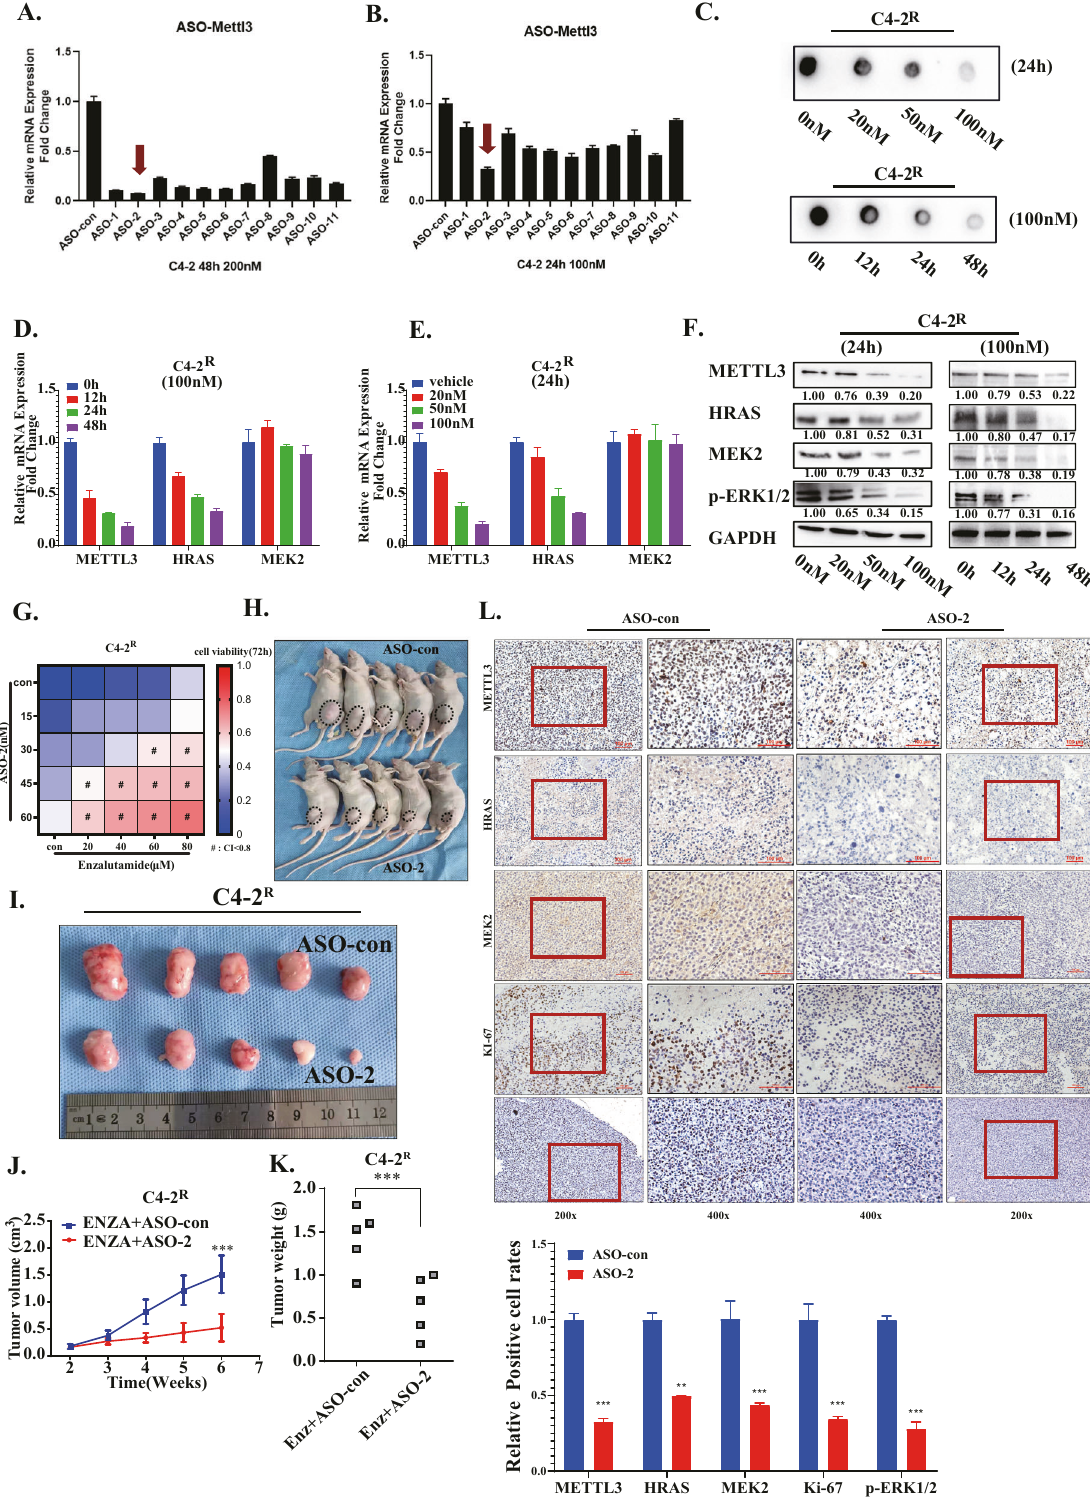
ASO design and usage We used the online RNA-motif prediction tool (Sfold) to screen 20 bp ASO sequences speci fi cally targeting METTL3 mRNA [27 – 30]. The mRNA sequence of METTL3 was obtained from NCBI. We selected 10 candidate ASOs including desired motifs [31] and modi fi ed them in the second generation “ GAPMER ” style, including phosphorothioate modi fi cation and